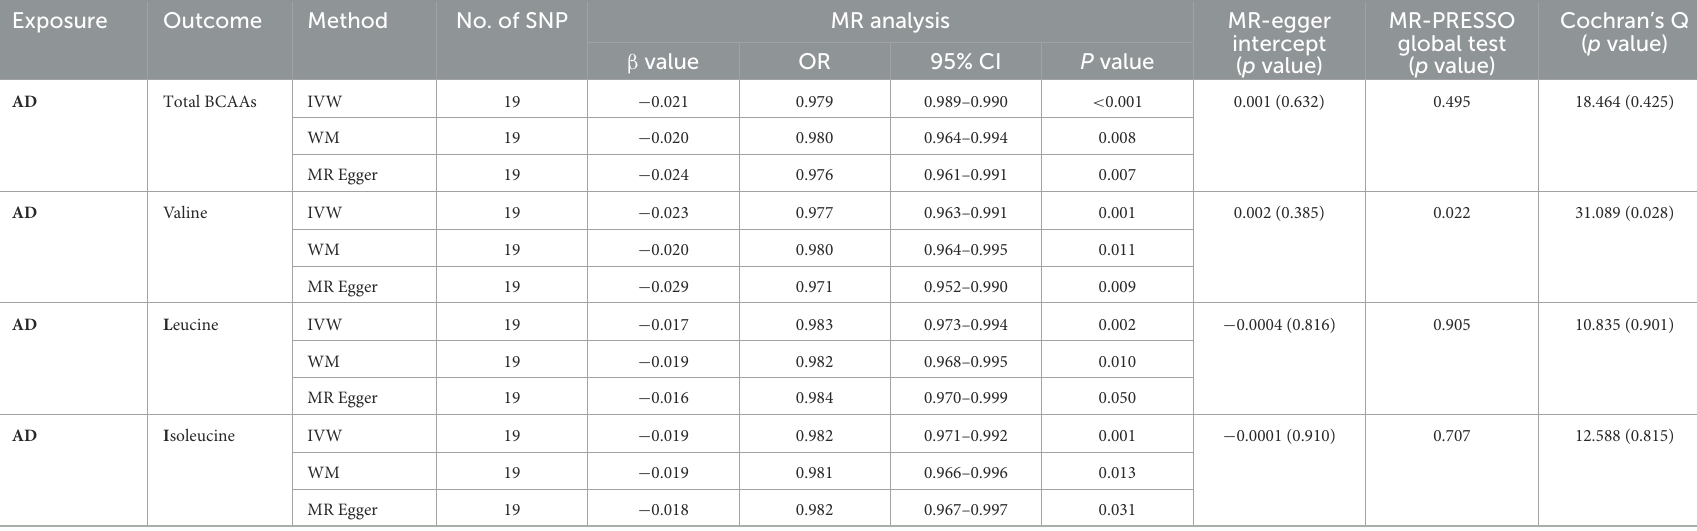
TABLE 2 Mendelian randomization analysis explore the genetic causal effects of AD on the level of